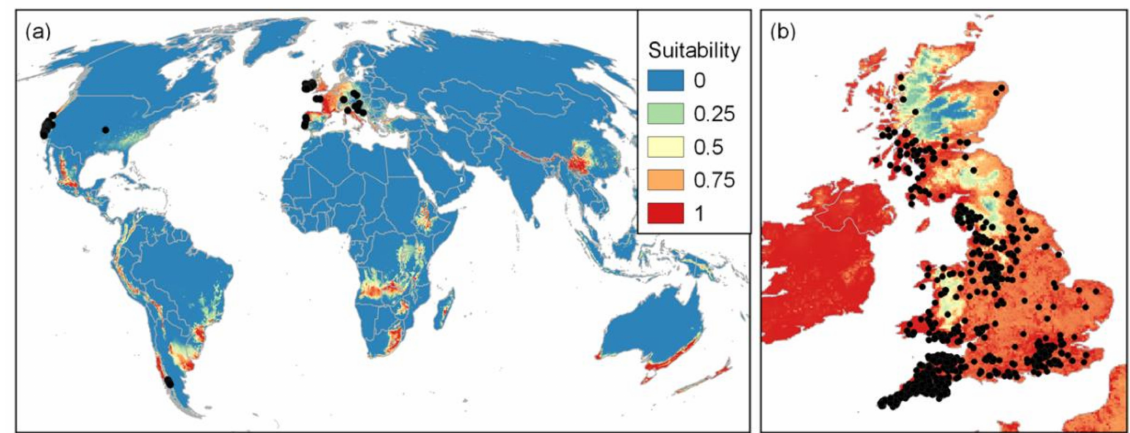
Figure 11. Global habitat suitability maps for Phytophthora ramorum where values are the predicted probability of occurrence of this species overlaid with ( a ) the global training dataset occurrences (black dots) and ( b ) UK validation occurrences from natural and outdoor managed environments (black dots) (AUC = 0.747, vs. all UK